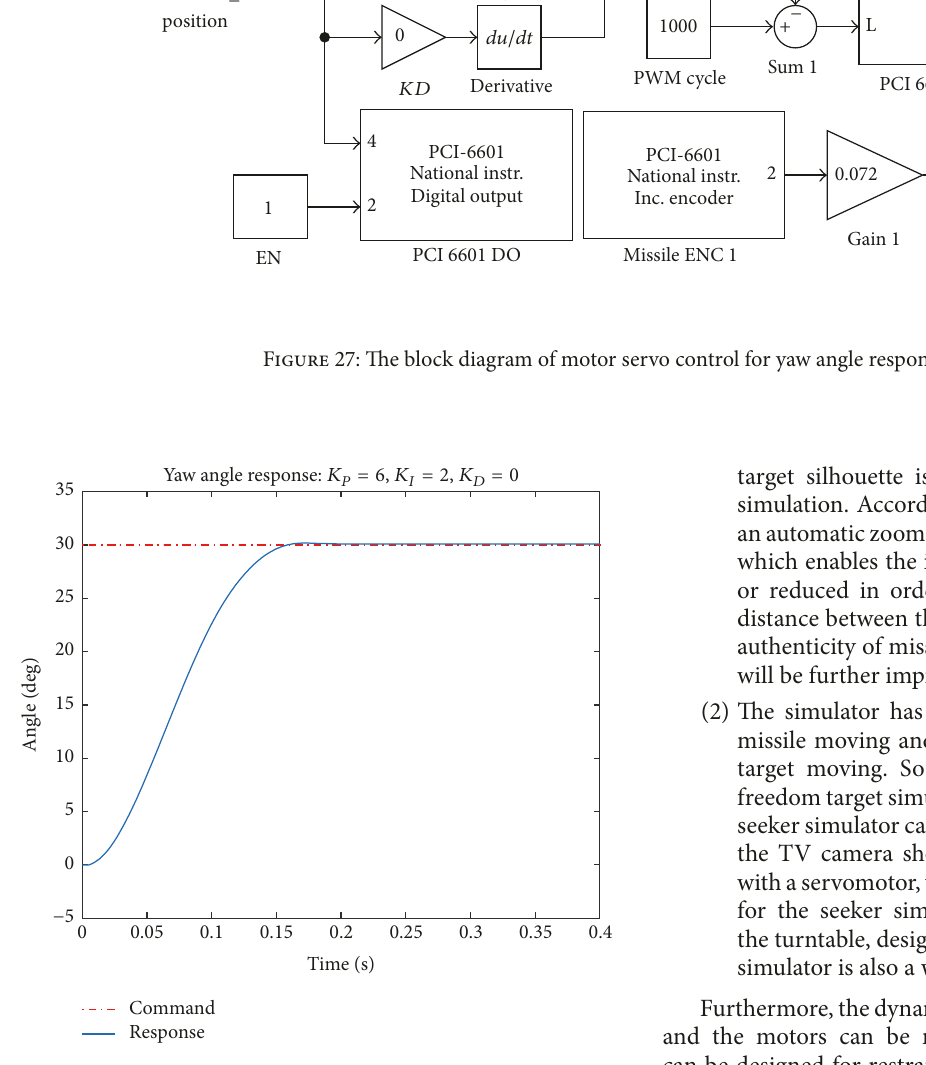
Figure 28: Yaw angle step